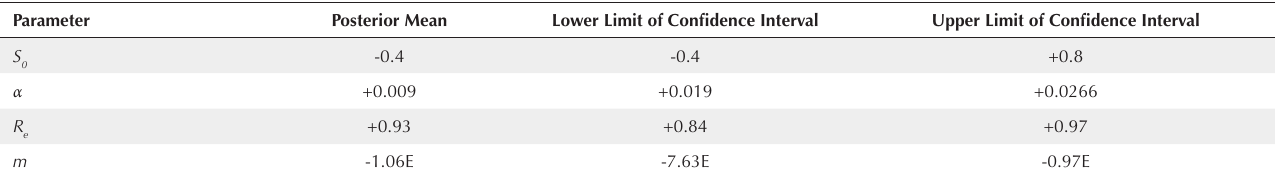
Table 2 . Sensitivity Analysis of Model Parameter Estimates Parameter